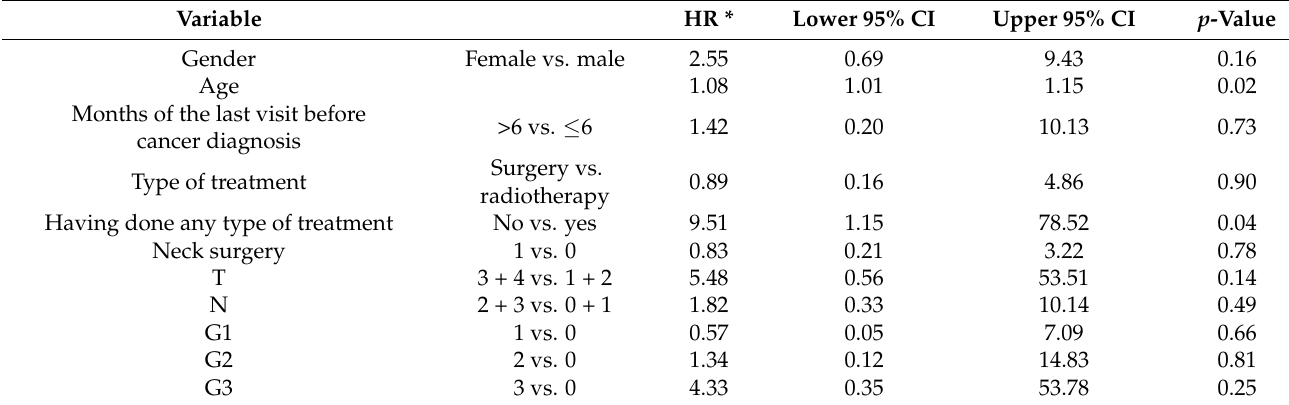
Table 4. The Cox proportional-hazards model conducted for investigating the association between survival time and cancer-related variables (T, N, grading parameters, site, and treatment).